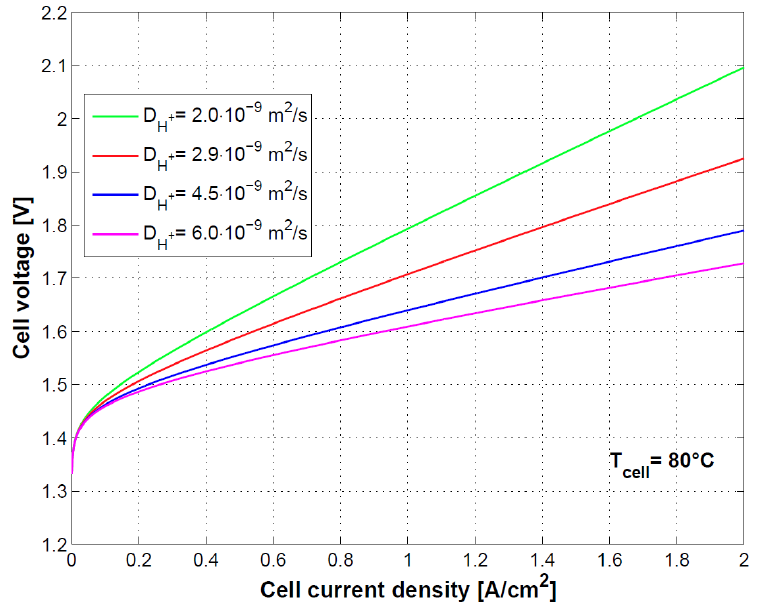
Figure 10. Influence of the cell polarization on H + ions diffusivity in Nafion membrane.